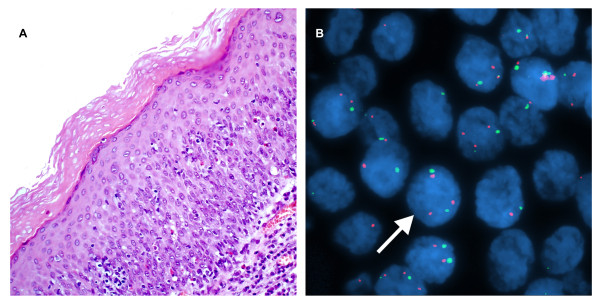
A case of moderate dysplasia of the larynx. A. H&E stain. (×200). B. Interphase FISH displaying a CSP3: hTERC signal pattern is 2:3 (green:red). (×1000).